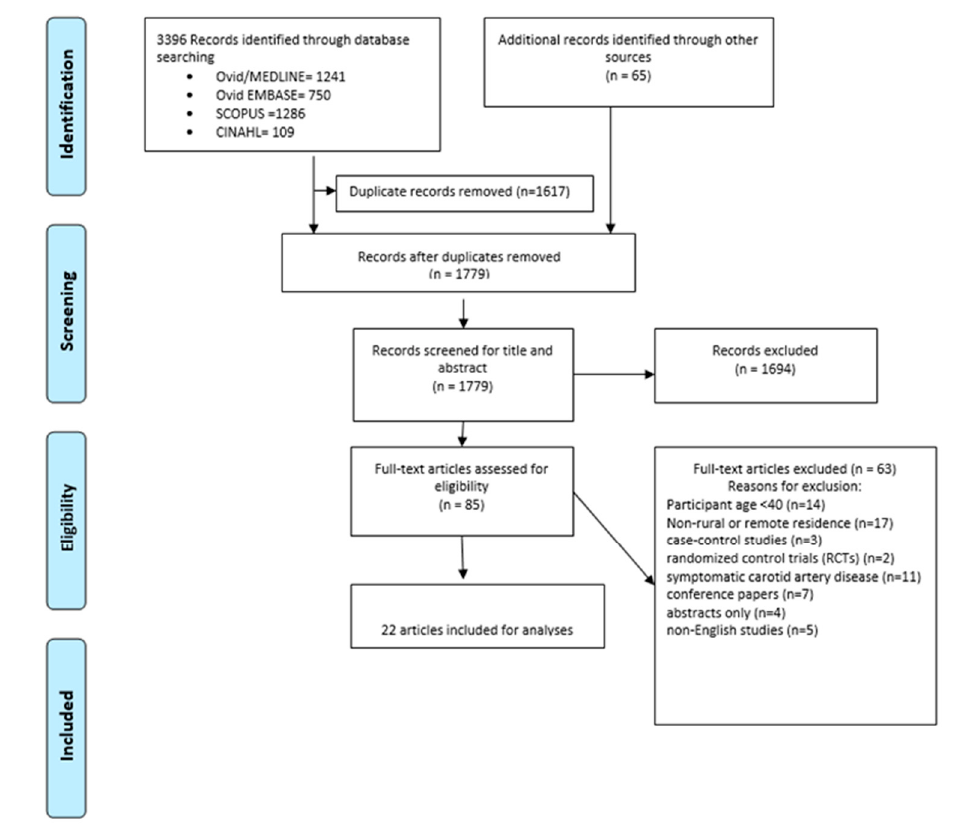
Figure 1. Study selection. Table 1. Detailed characteristics of included studies (n =